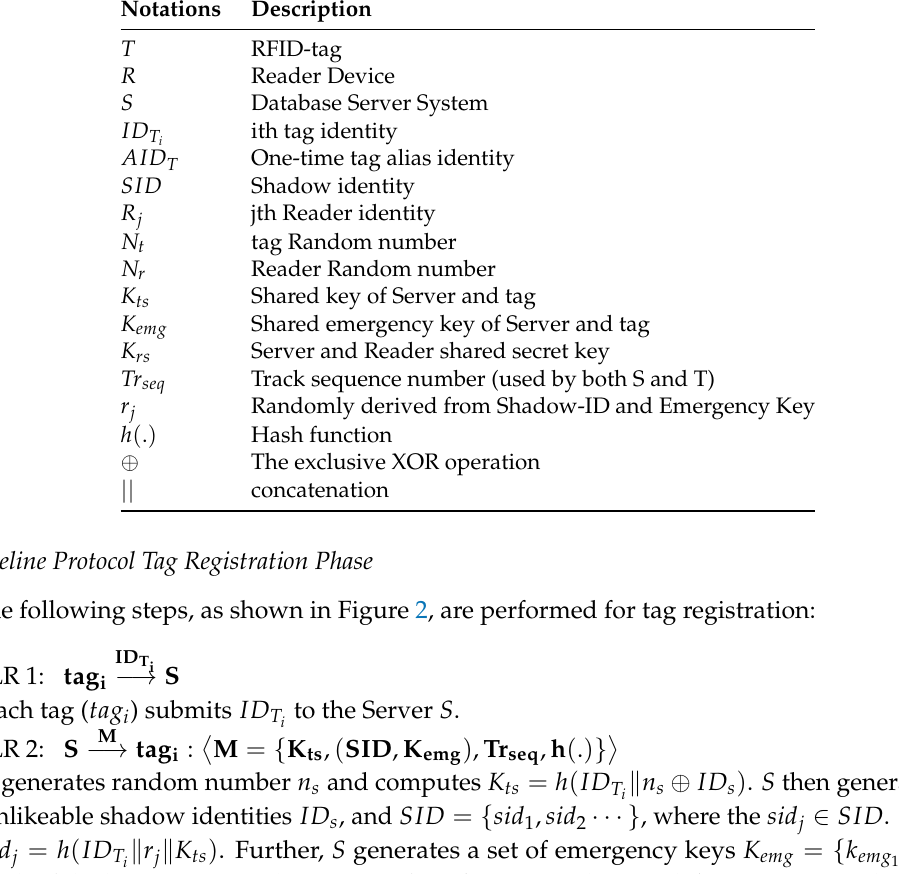
Table 2. Notation